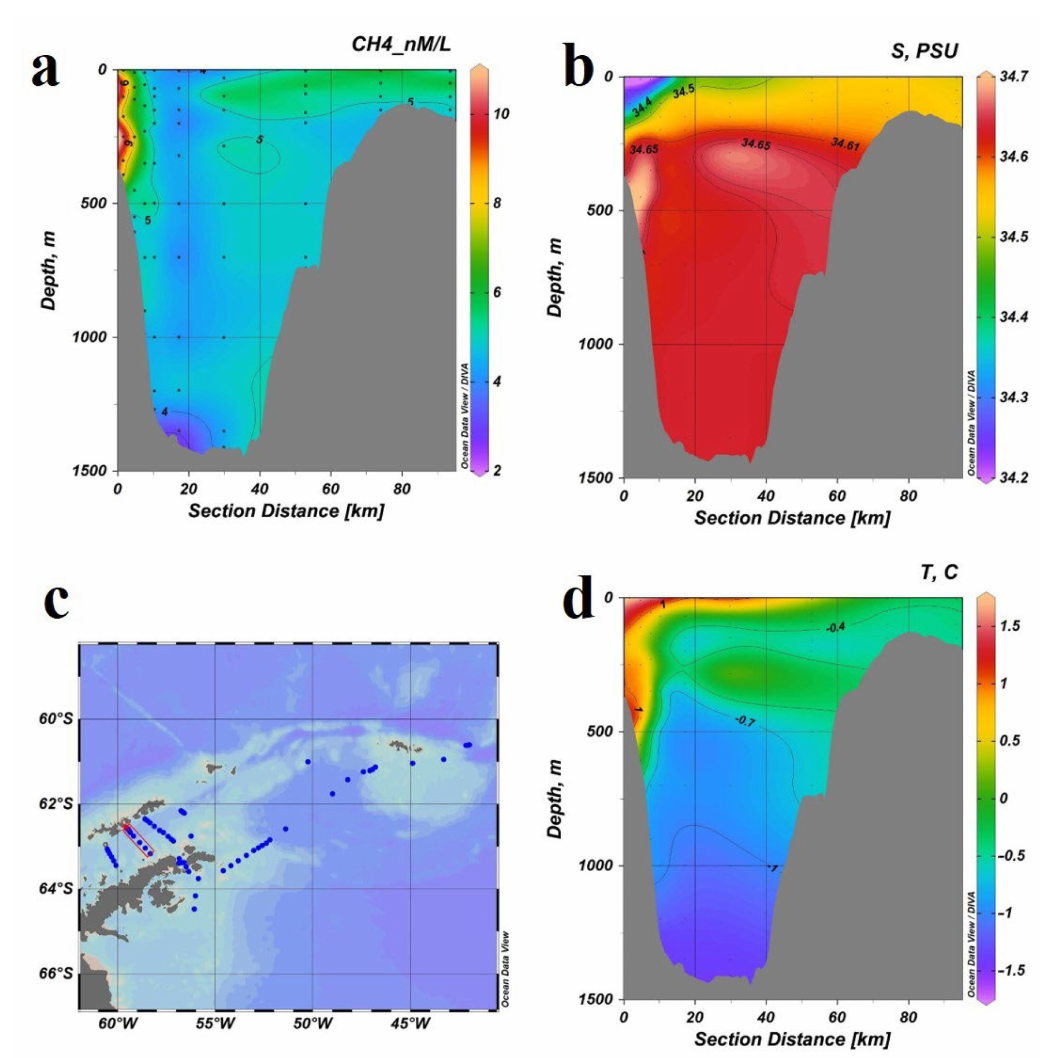
Figure 3. Distribution of methane concentration ( a ), temperature ( d ) and salinity ( b ) in the central section ( c ) in the Bransfield